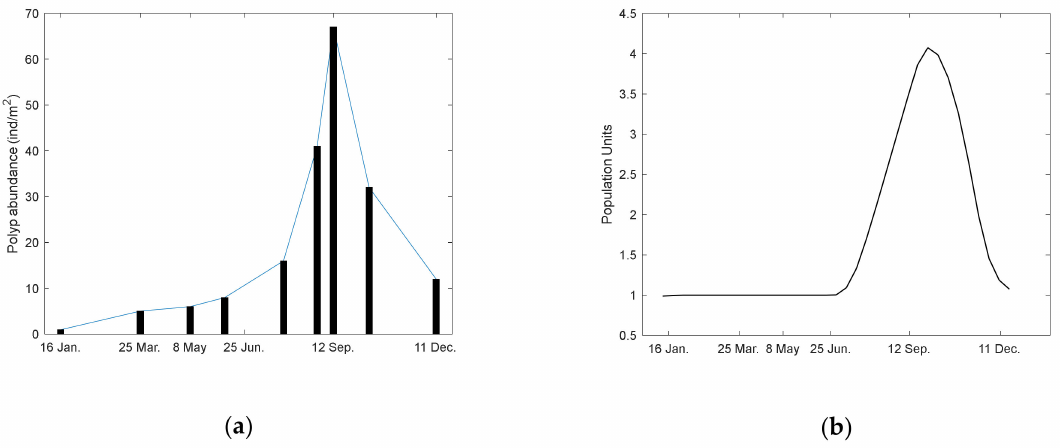
Figure 3. ( a ) Observed Aurelia coerulea polyp abundance [bar] [13] and the interpolated curve. ( b ) simulated polyp population.